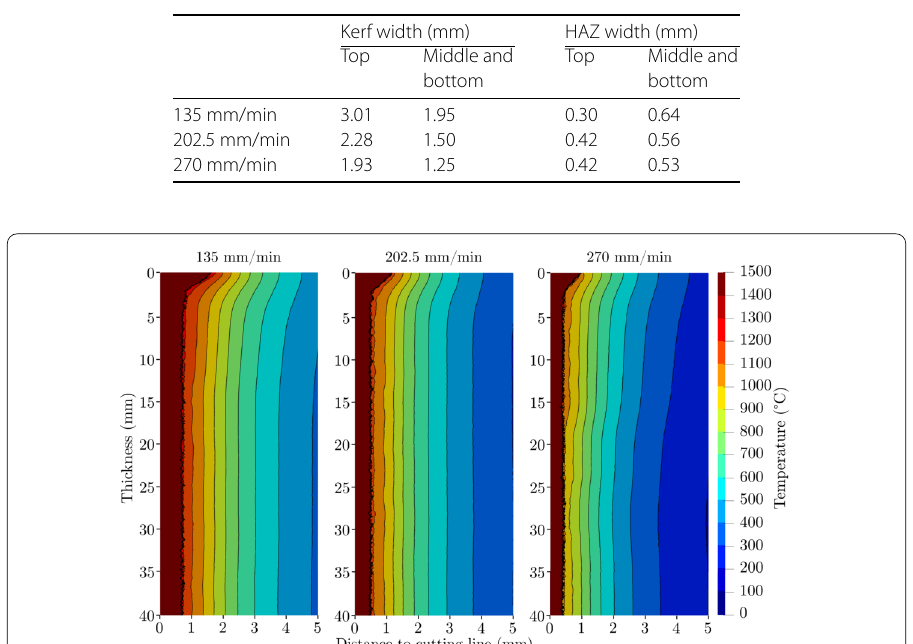
Figure 12 Isothermal contours in the remaining plate for different